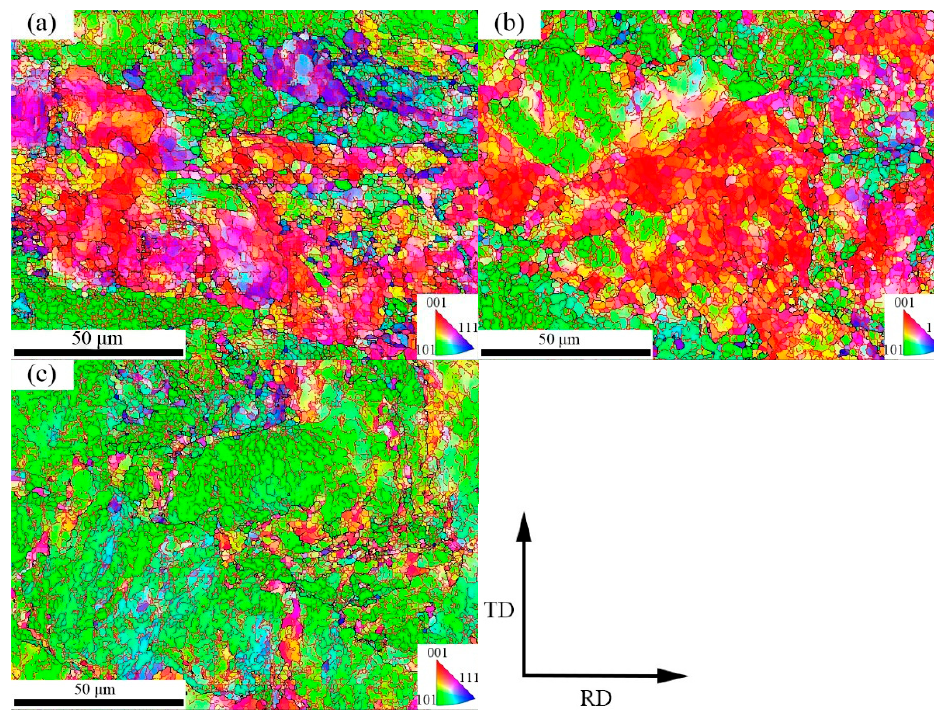
Figure 8. EBSD surface IPF orientation maps of samples rolled with different deformation temper-